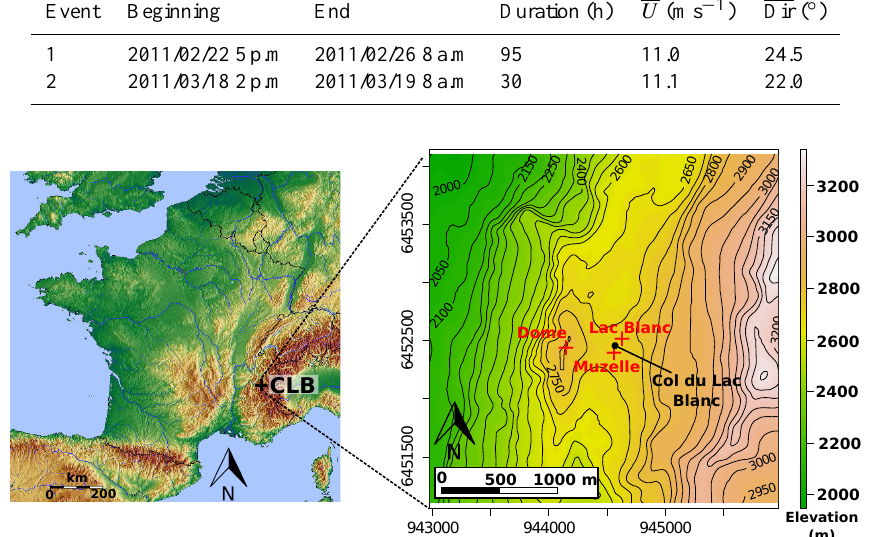
Fig. 3. Location of the study site Col du Lac Blanc (CLB) in the French Alps and orography of the surrounding area. Red crosses indicates automatic weather stations. Meteorological mast and SPC are located at Col du Lac Blanc (black dot). The black isolines correspond to 1z =